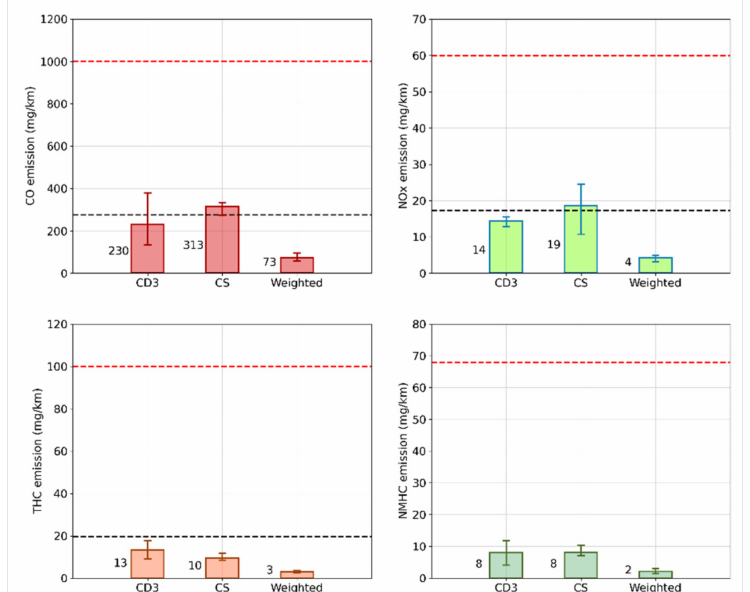
Figure 1. Regulated emissions on WLTC tests at 23 ◦ C, averages of the three vehicles. CD3 indicates the third cycle in the charge-depleting sequence (for all vehicles, this was the cycle in which the ICE ignited for the first time). Started with an initial battery state of charge (SOC) equal to 100%; CS indicates the cold-start charge-sustaining cycle performed after the battery depleting sequence, i.e., starting with the minimum SOC. Weighted indicates emissions calculated according to the procedure reported in the currently in-force EU regulation [16]. Red dashed lines represent the Euro 6 regulatory limits, black dashed lines represent average emissions from the fleet of gasoline direct-injection vehicles tested at the JRC in the 2018–2019 period, in the framework of the MaSu activity on the same cycle [18]. All tests were performed in the default user-selectable mode of operation. Error bars on the graph represent maximum and minimum values. See the Methods section for additional